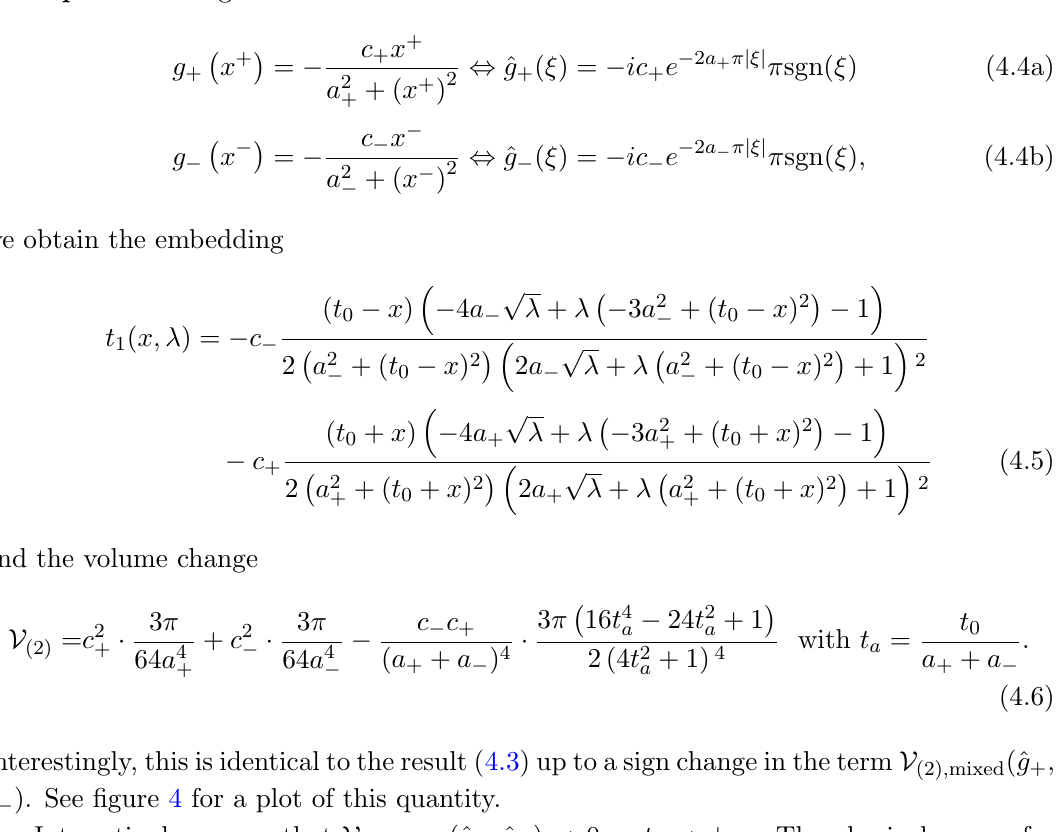
Figure 4 . Plot of the term V example 2. For t 0 ! (cid:6)1 , V